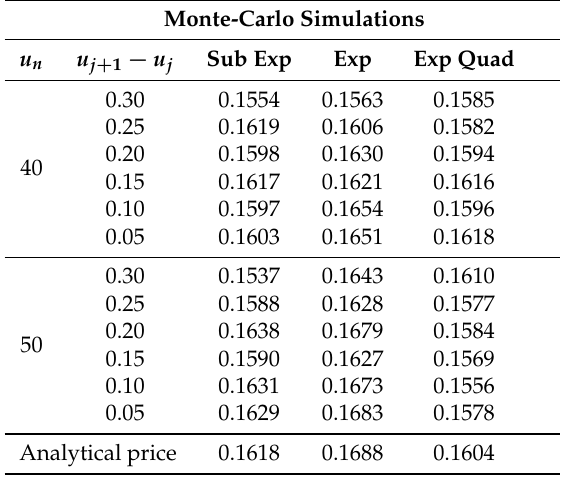
Table 8. Model parameters: Brent vs. WTI oil. Number of lags: 150 days and d = 2. The last columns contain values of λ k used to test the sensitivity of option prices to autocovariance parameters.